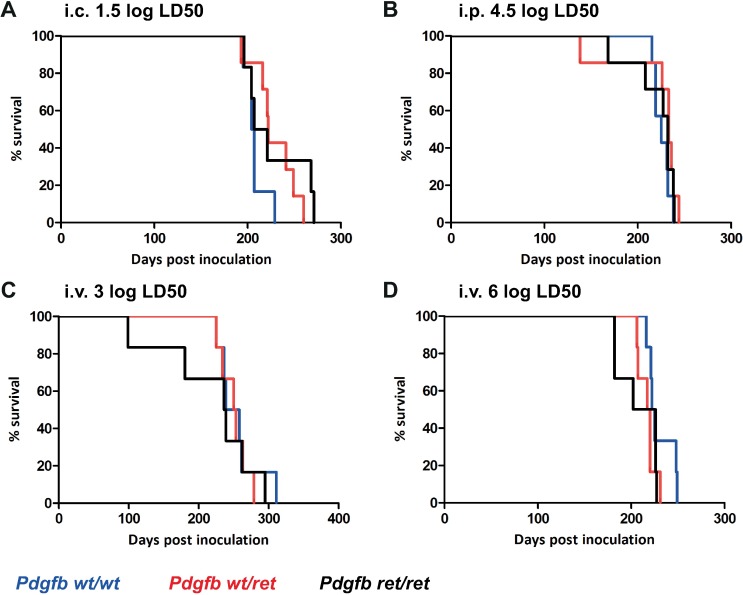
Increased BBB permeability does not alter prion disease incubation.(A-D) Kaplan-Meier survival curves of Pdgfbwt/wt, Pdgfbwt/ret, Pdgfbret/ret animals inoculated with RML6 intracerebrally (A) (1.5 log LD50
Pdgfbwt/wt n = 6, 205.5 dpi; Pdgfbwt/ret n = 7, 222 dpi; Pdgfbret/ret n = 6, 214 dpi, P = 0.22), intraperitoneally (B) (4.5 log LD50
Pdgfbwt/wt n = 7, 225 dpi; Pdgfbwt/ret n = 7, 233 dpi; Pdgfbret/ret n = 7, 232 dpi, P = 0.41) or intravenously (C, D) (3 log LD50 (C) Pdgfbwt/wt n = 6, 248.5 dpi; Pdgfbwt/ret n = 6, 237.5 dpi; Pdgfbret/ret n = 6, 237.5 dpi, P = 0.86 and 6 log LD50 (D) Pdgfbwt/wt n = 6, 223.5 dpi; Pdgfbwt/ret n = 6, 218.5 dpi; Pdgfbret/ret n = 6, 214 dpi, P = 0.37).